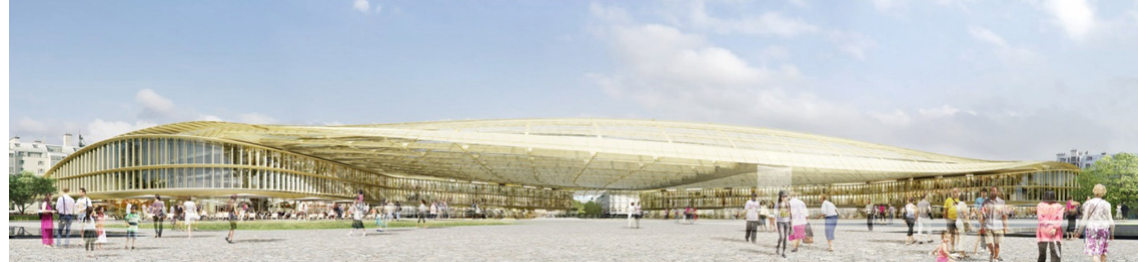
Fig. 1 Canopée Paris – Global